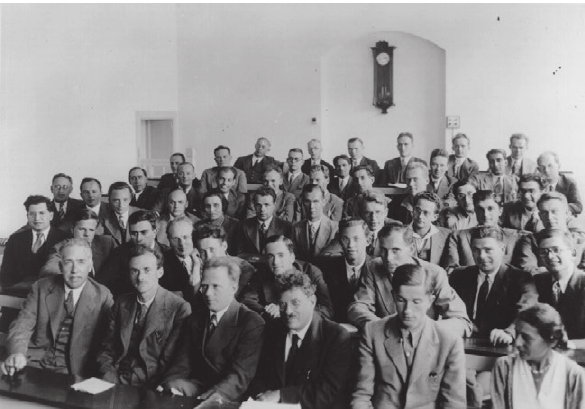
Figure 3. Milton Plesset (left) with N. Bohr, F. Kalckar, E. Teller, and O. Frisch at the Copenhagen institute in 1934. Credit: Niels Bohr Archive, Photo Collection,